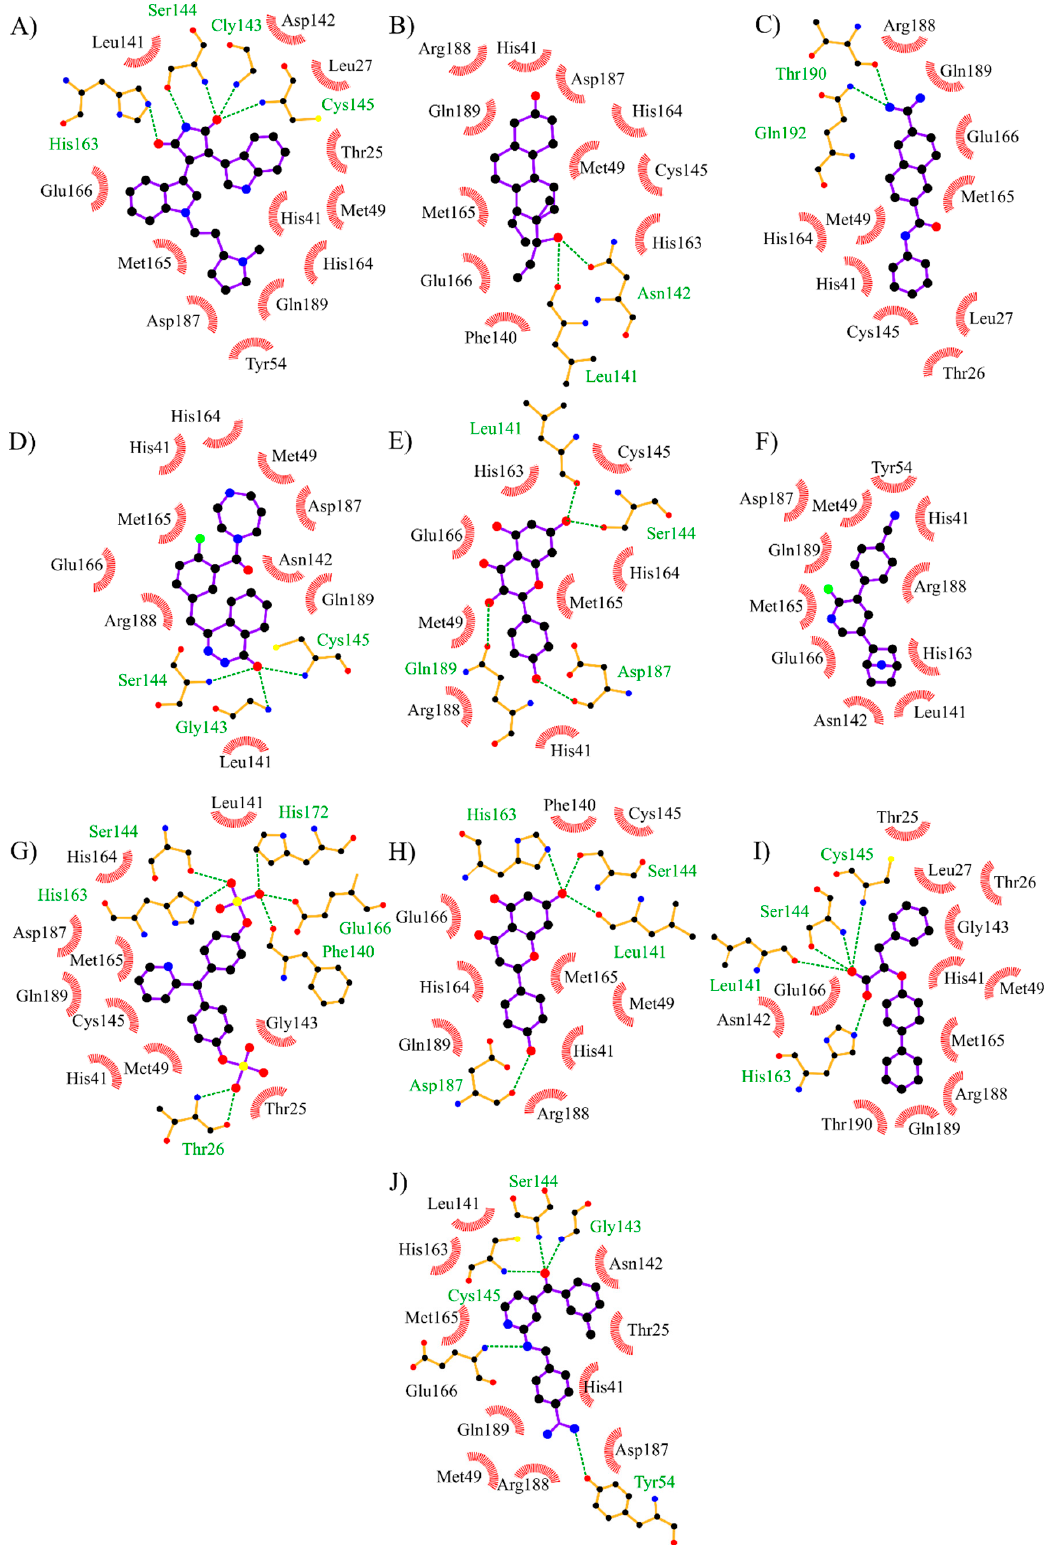
Figure 6. The top 10 potential inhibitors of SARS-CoV-2 Mpro obtained from DrugBank by fingerprints and molecular docking. ( A ) DB07458 (D.S.: − 8.6 kcal/mol) ( B ) DB09371 (D.S.: − 8.5 kcal/mol) ( C ) DB01977 (D.S.: − 8.0 kcal/mol) ( D ) DB08058 (D.S.: − 8.0 kcal/mol) ( E ) DB01852 (D.S.: − 7.9 kcal / mol). ( F ) DB14029 (D.S.: − 7.9 kcal / mol) ( G ) DB09268 (D.S.: − 7.9 kcal / mol) ( H ) DB07352 (D.S.: − 7.8 kcal / mol). ( I ) DB08121 (D.S.: − 7.8 kcal / mol) ( J ) DB07809 (D.S.: − 7.8 kcal / mol). D.S.: Docking